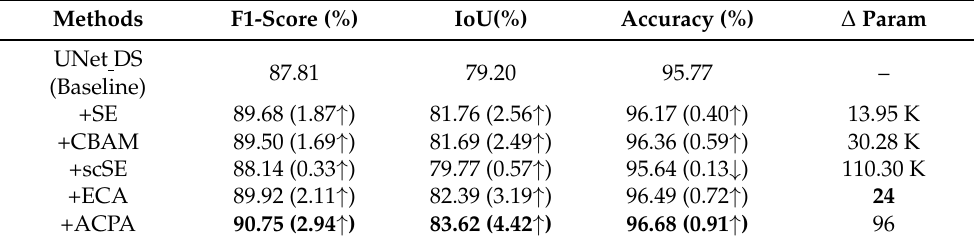
Figure 5. Visualization of segmentation results of each component inserted into the baseline. Table 2. Ablation with different attention modules, where UNet+DS serves as the